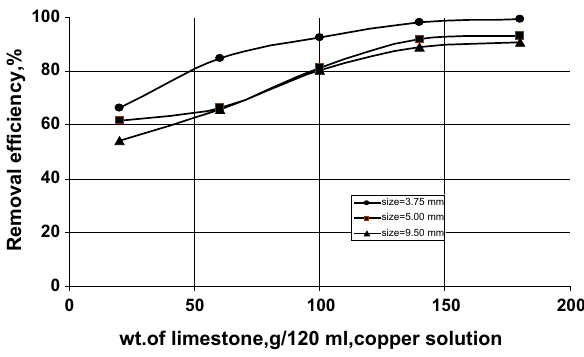
Fig. 5 The effect of volume of limestone on effluent copper concen- tration for middle influent concentration of copper (4.39 mg/l)